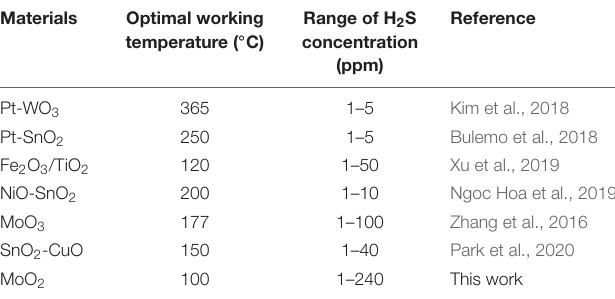
TABLE 1 | Comparison of sensing performance between MMO and other metal oxide.